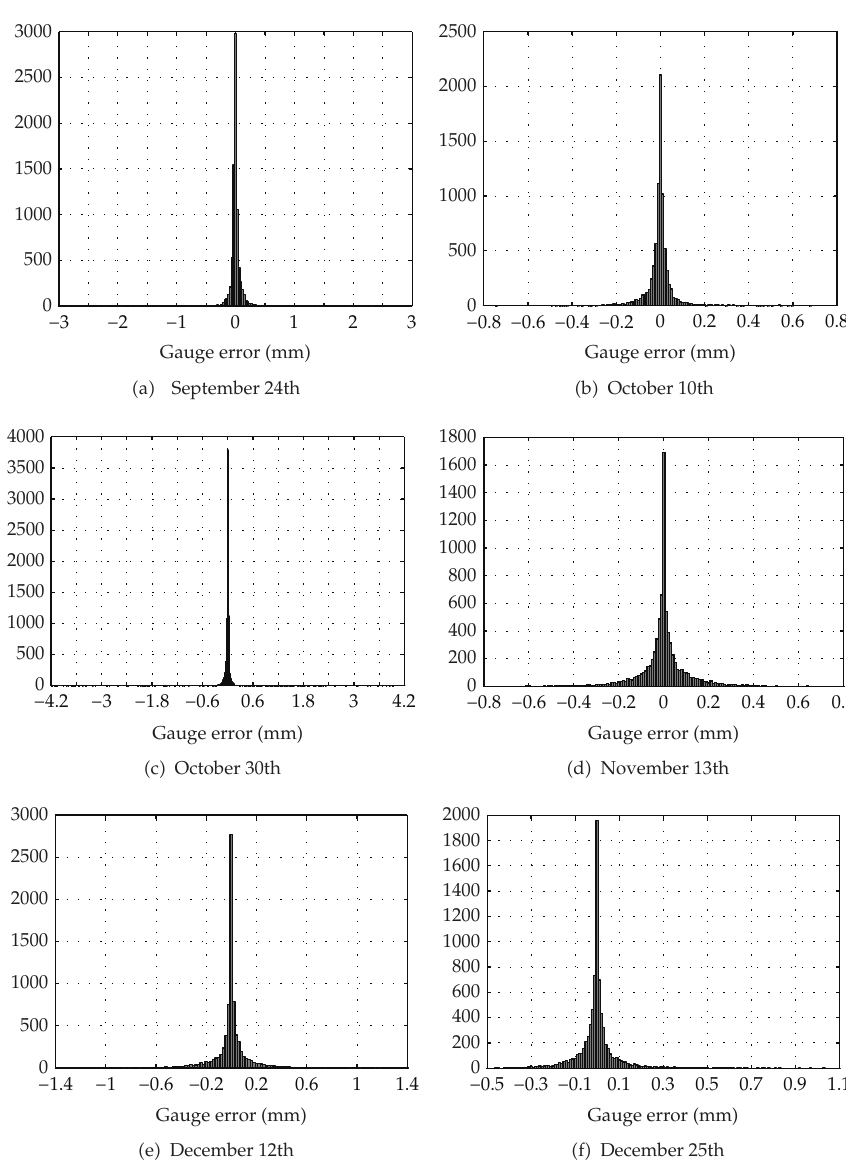
Figure 4: Histograms on errors in gauge predictions of all sampling points in Jiulong-Beijing track section from K612 (cid:8) 000 to K614 (cid:8)